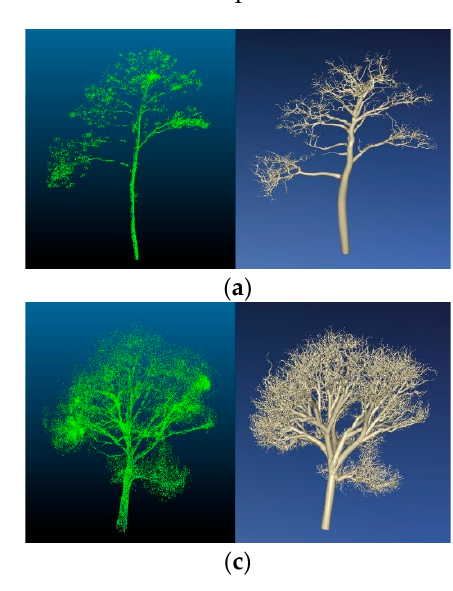
Figure 6. Reconstruction results corresponding to ( left ) tree point cloud of four different morphologies ( right ) are shown. ( a ) This is a young tree; ( b ) this tree has a large crown with distinctive features ( c ) this tree has dense branches and leaves. ( d ) The tree is deformed and the trunk is not perpendicular to the ground.